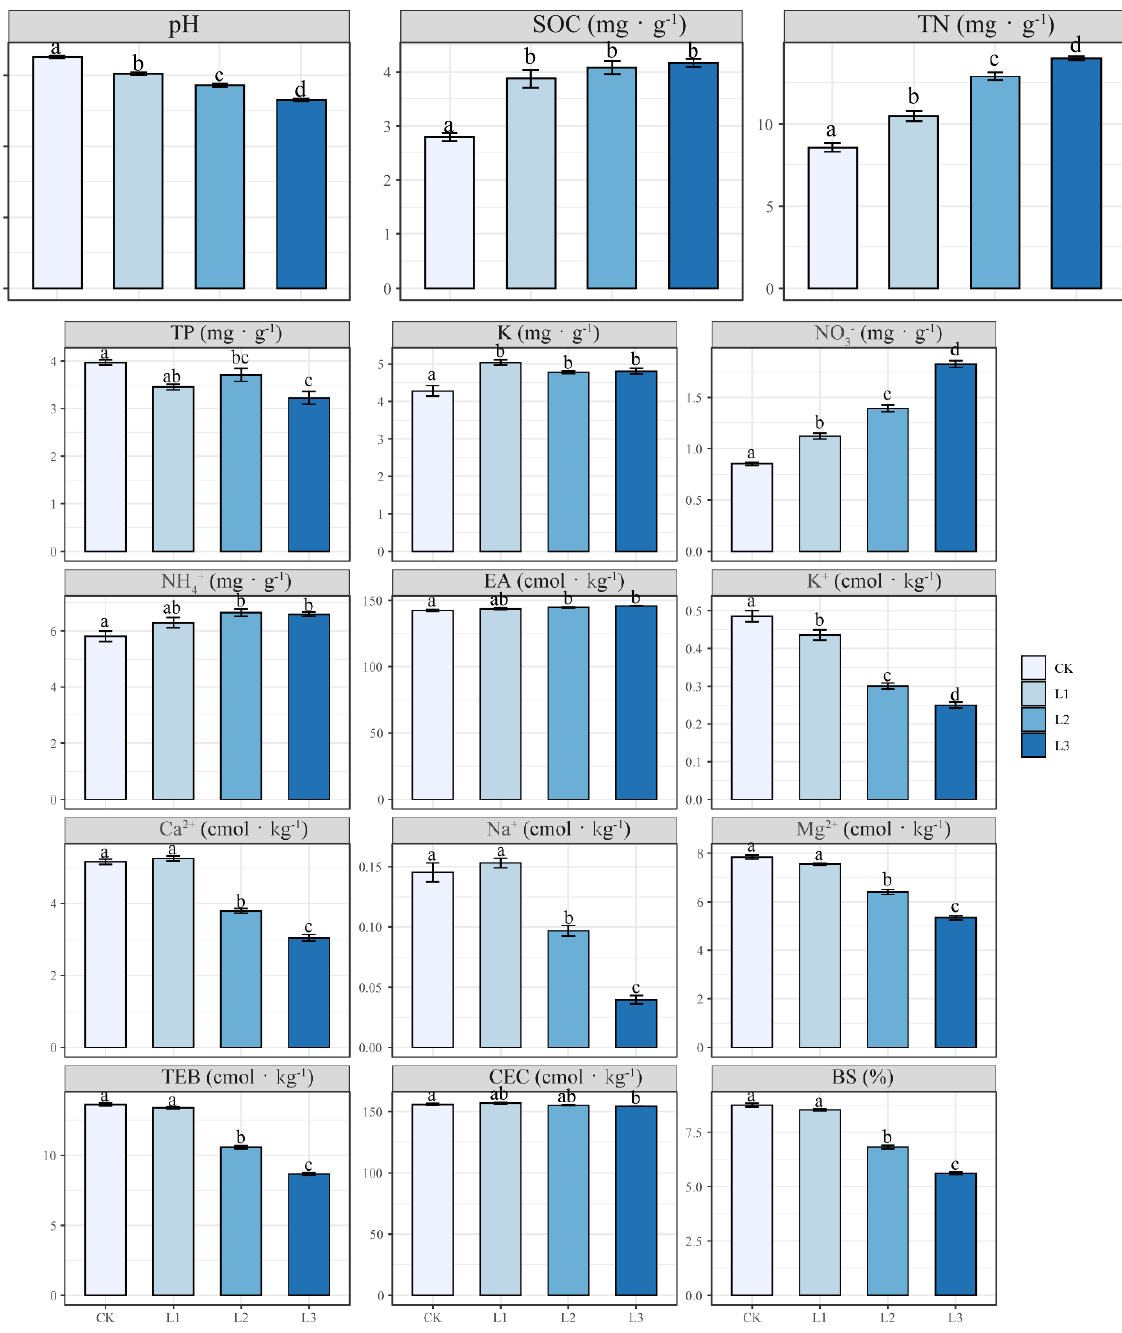
Figure 3. The concentration of soil parameters in different N addition treatments. Bars represent mean value with the standard error (±SE). Different colors indicate the different treatments. Different letters indicate the significance among different levels of N application ( p < 0.05).